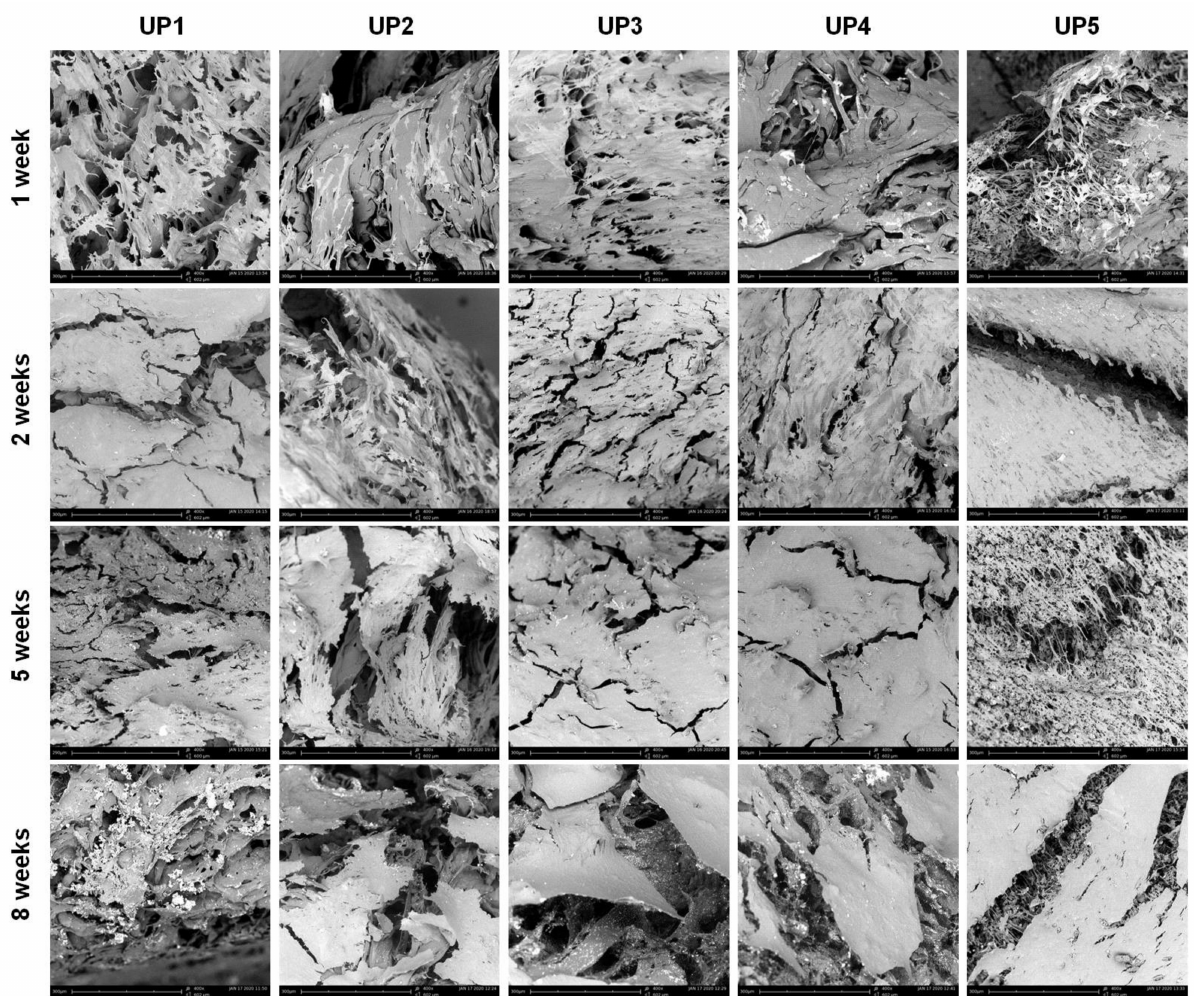
Figure 7. SEM images of UP scaffolds seeded with hADMSCs, depicting the adhesion and spreading of hADMSCs on the porous structure of the scaffolds after 1 week culture in MSC expansion medium and 2, 5 and 8 weeks culture in osteogenic differentiation